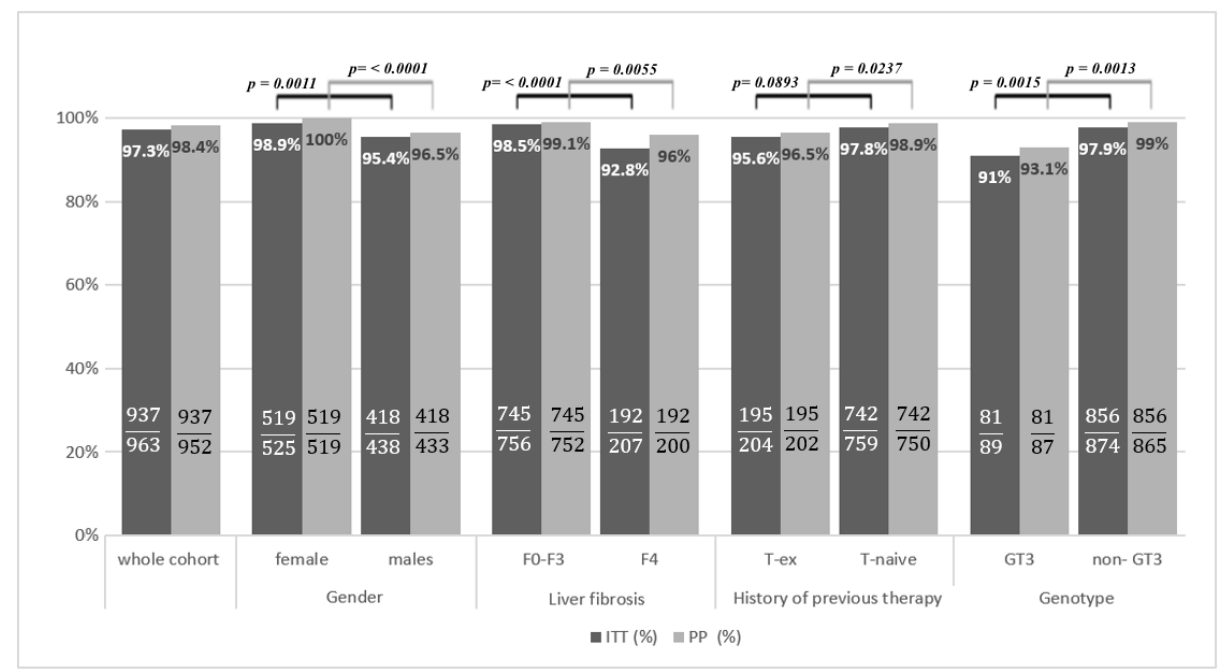
Figure 1. The comparison of SVR in the subpopulations. F: fibrosis; GT, genotype; ITT: intention-to-treat; PP: Per-protocol; SVR: sustained virologic response; T-ex: treatment experience; T-naive: treatment naive.